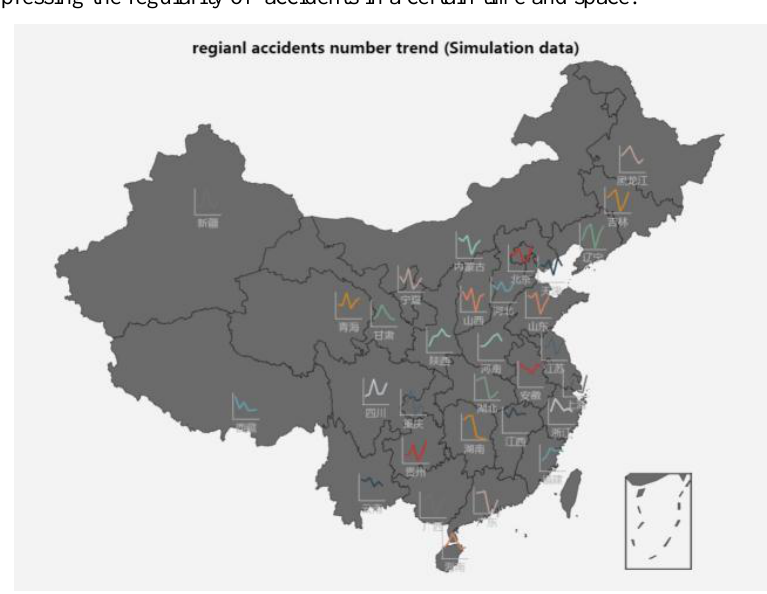
Figure 6 superimposing the time-line chart for different regions on the map. (simulating